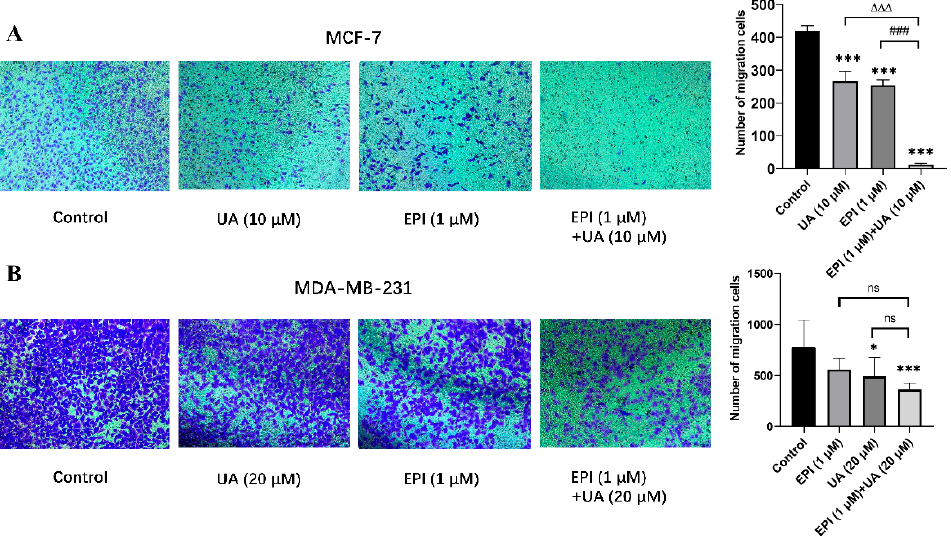
Figure 3. The effects of UA and/or EPI on the migration of MCF-7 and MDA-MB-231 cells. ( A ) MCF-7 cells were incubated with 10 μ M of UA or 1 μ M of EPI, or the two in combination for 24 h. ( B ) MDA-MB-231 cells were incubated with 20 μ M of UA or 1 μ M of EPI, or the two in combination for 24 h. The means and SEM were shown. n = 3. * p < 0.05 and *** p < 0.001 versus control group in the absence of any treatments; ### p < 0.001 versus EPI-treated alone group; ∆∆∆ p < 0.001 versus UA-treated alone group. The value bars with ns are not significant.